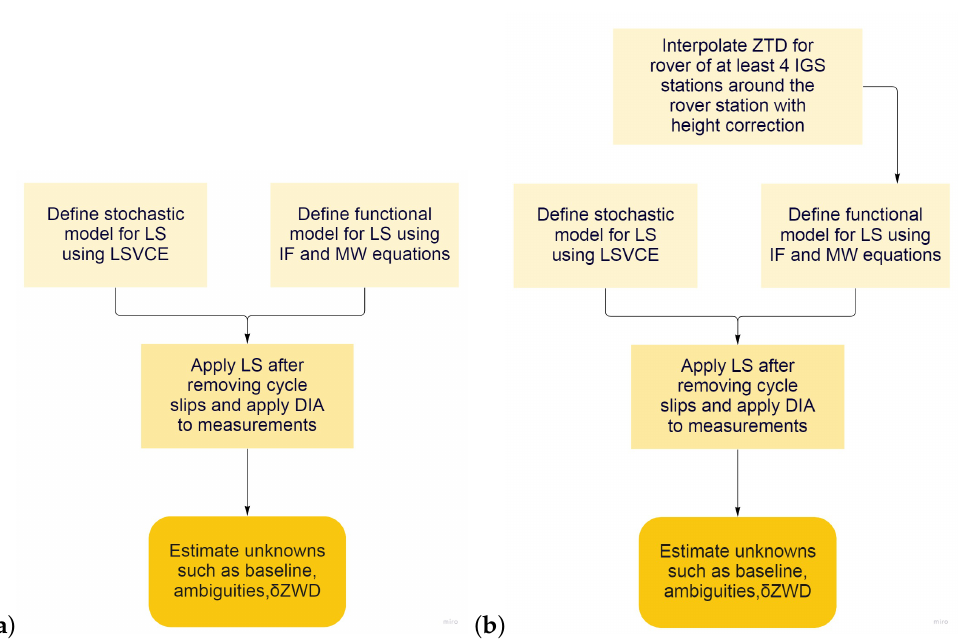
Figure 2. Simple flowchart for the estimation producer: ( a ) Tropospheric-float model; ( b ) Tropospheric-weighted